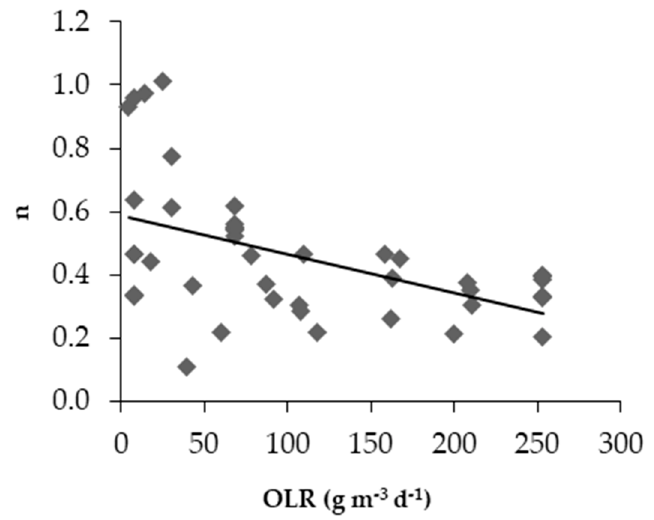
Figure 1. Association (trend) between the n coefficient and total organic loading rate (as